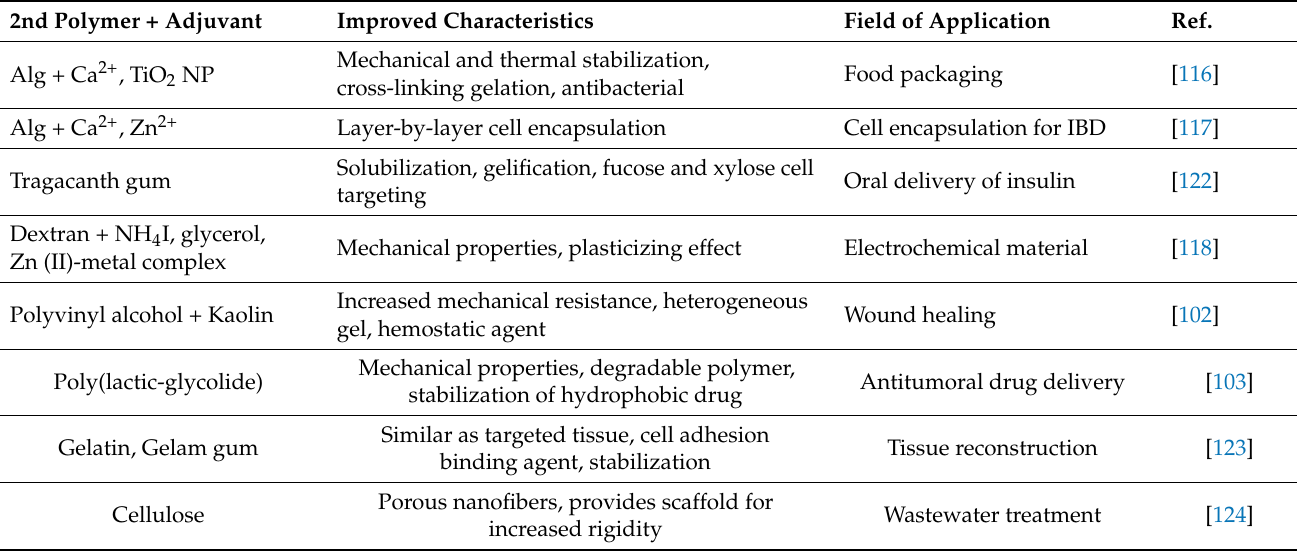
Table 2. Relevant examples of polymers mixed with non-functionalized CS to form non-covalent complexes. The type of polymers and small adjuvants are listed, as well as the improved characteristics of interest and the field of application. 2nd Polymer +